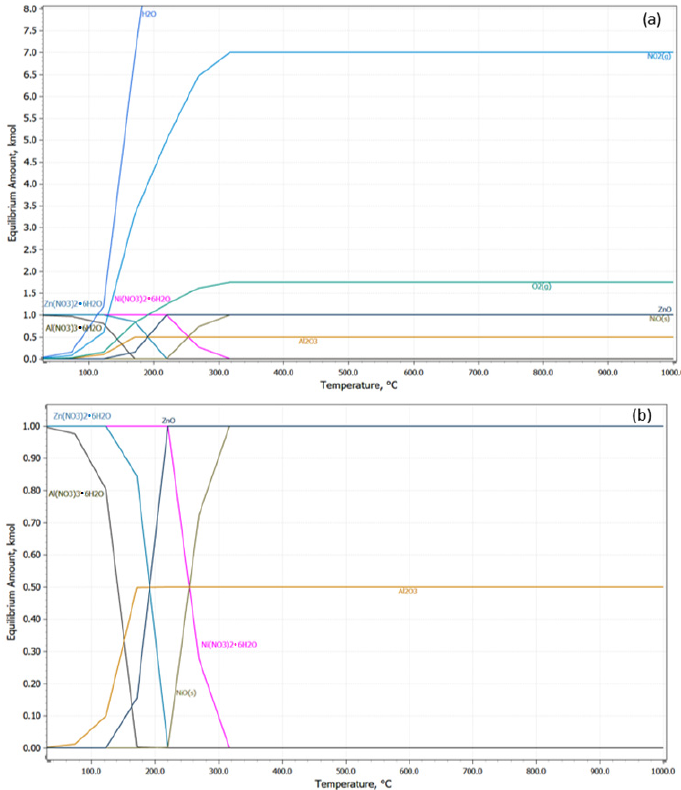
Figure 3. ( a ) Calculated reaction equilibrium amounts for decomposition reactions of metal nitrates. ( b ) Shows the magnified region of the graphic ( a ) (between Equilibrium amounts, kmol 0.00–1.00).